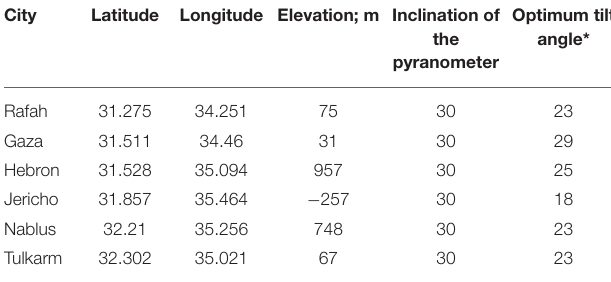
TABLE 1 | Geographical data for selected